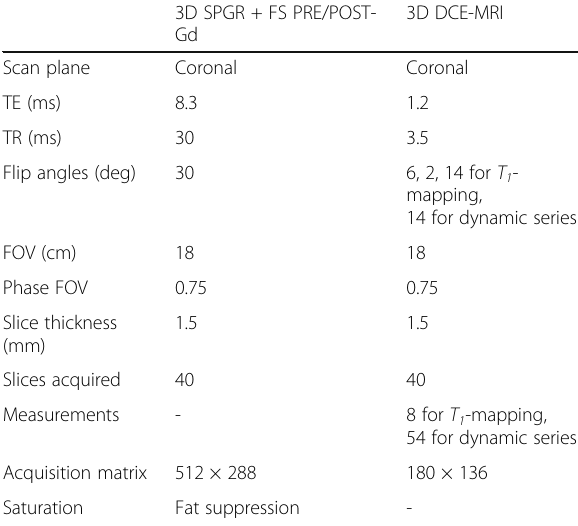
Table 1 MRI scanning parameters for structural and